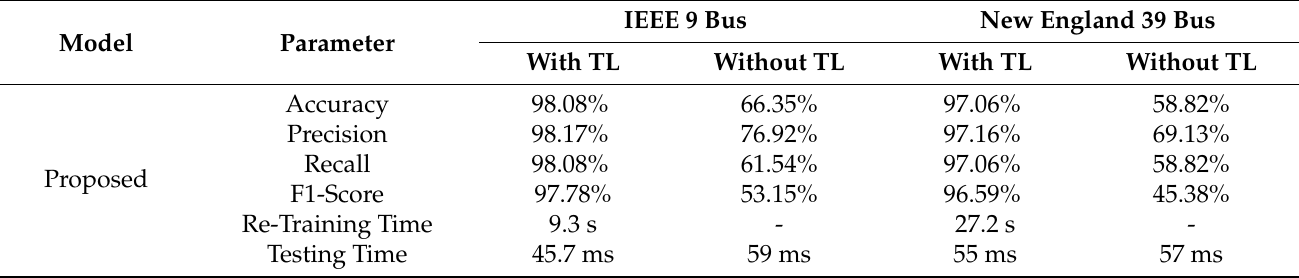
Table 7. Comparison of performance using proposed transfer learning method for N-1 contin- gency